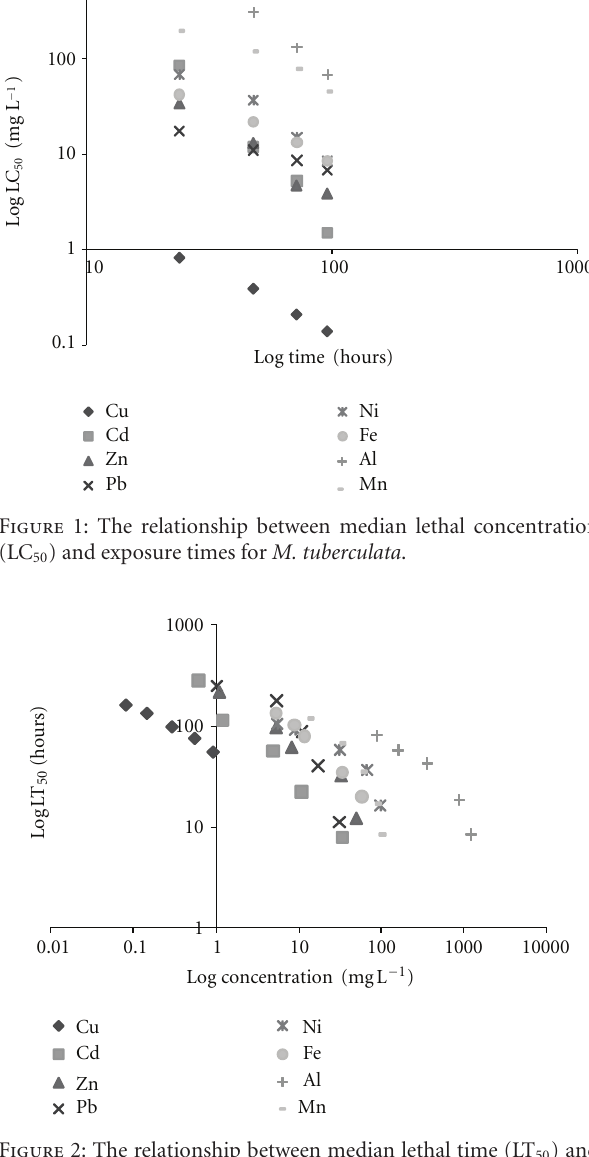
Figure 2: The relationship between median lethal time (LT 50 ) and exposure concentrations for M. tuberculata